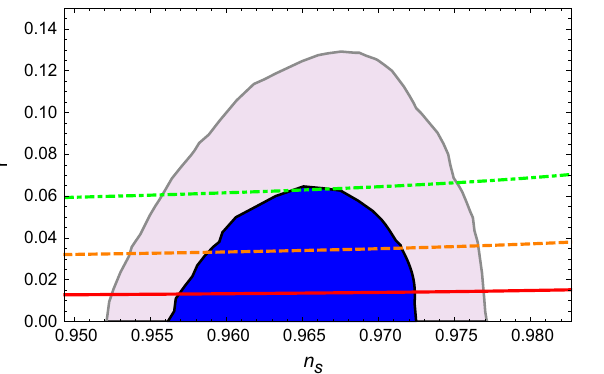
Fig. 3 r − n s diagram. The area corresponds to Planck data and r − n s trajectories relate to our model. The solid red, dashed orange and dot- dashed green lines are correspond to dissipation parameter Γ 0 as : 8 × 10 − 7 , 4 × 10 − 7 , 2 × 10 − 7 . There is a constrain of dissipation parameter Γ > 2 × 10 − 20 for the curves inside the 1- σ Planck contour. In these 0 curves we have fixed (ξ 2 , C γ ) as: (10 8 λ, 70) and the number of e-folds as: N e = 60